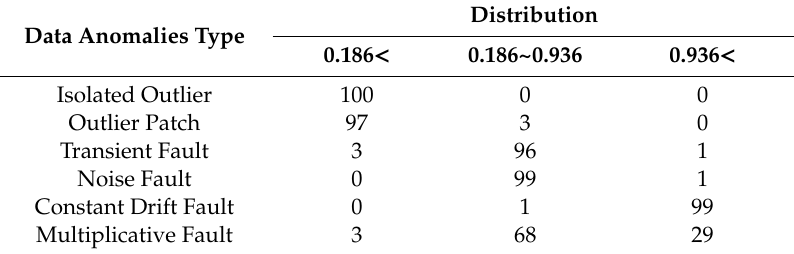
Figure 8. The distribution of the proportion of error points in different situations. Table 2. The distribution of the proportion of error points in different situations.